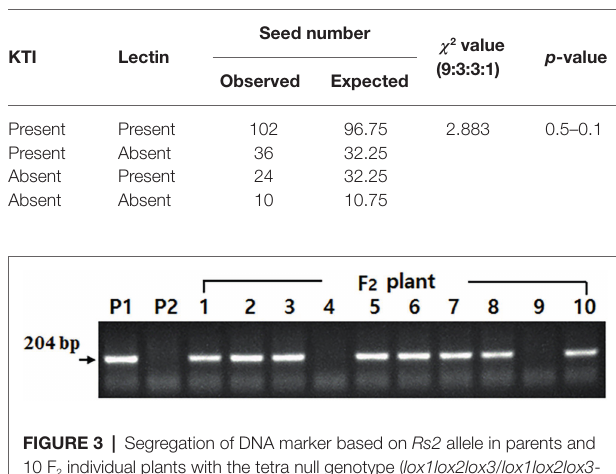
TABLE 2 | Segregation for the presence (+) or absence ( − ) of Kunitz trypsin inhibitor (KTI) and lectin proteins in F 2 seed generation derived from the cross of a lox1lox2lox3 / lox1lox2lox3 - rs2 / rs2 - cgy1 / cgy1 parent and lox1lox2lox3 / lox1lox2lox3 - ti / ti - le / le - cgy1/cgy1 parent.